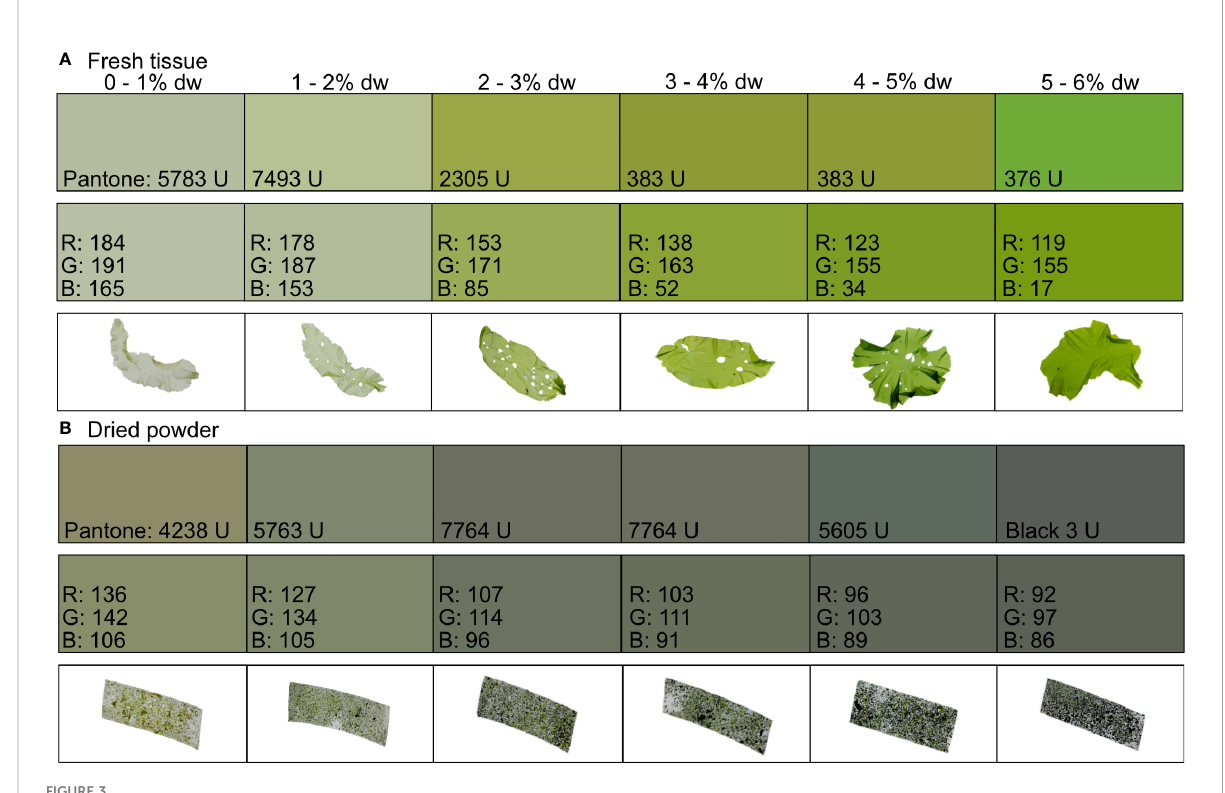
FIGURE 3 Color guide with the matched Pantone ® uncoated matt color to the red (R), green (G), and blue (B) values of the (A) fresh tissue and (B) dried powder of Ulva fenestrata divided into six different groups based on its nitrogen content (%